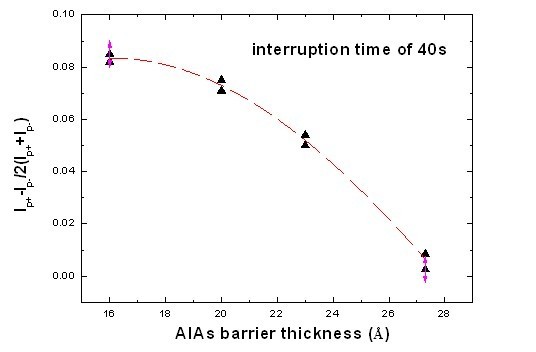
I-V asymmetry dependence with an AlAs barrier thickness of 1.6 ~ 2.73 nm. I-V asymmetry dependence with an AlAs barrier thickness of 1.6 ~ 2.73 nm and an interruption time of 40 s at the AlAs/In0.53Ga0.47As interfaces.